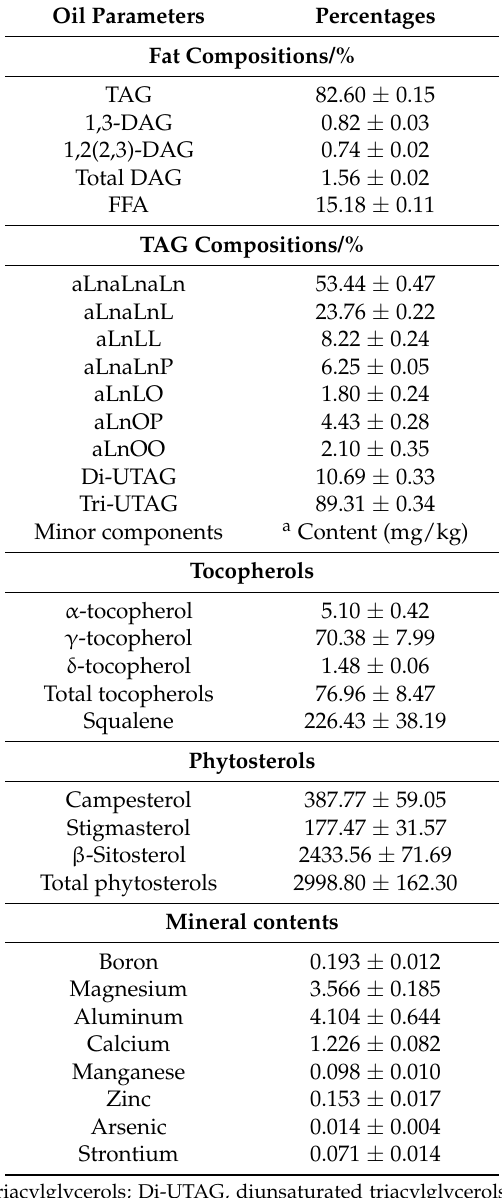
Table 2. Fat, TAGs and minor components of chia seed